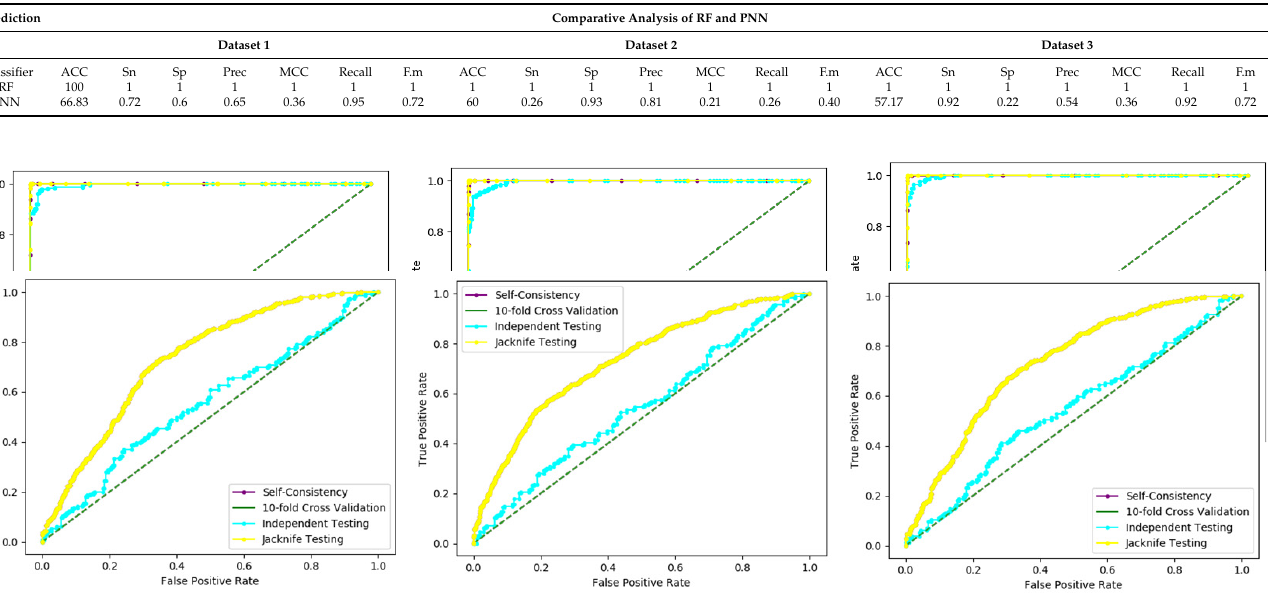
Figure 16. ROC curves through Probabilistic Neural Network.